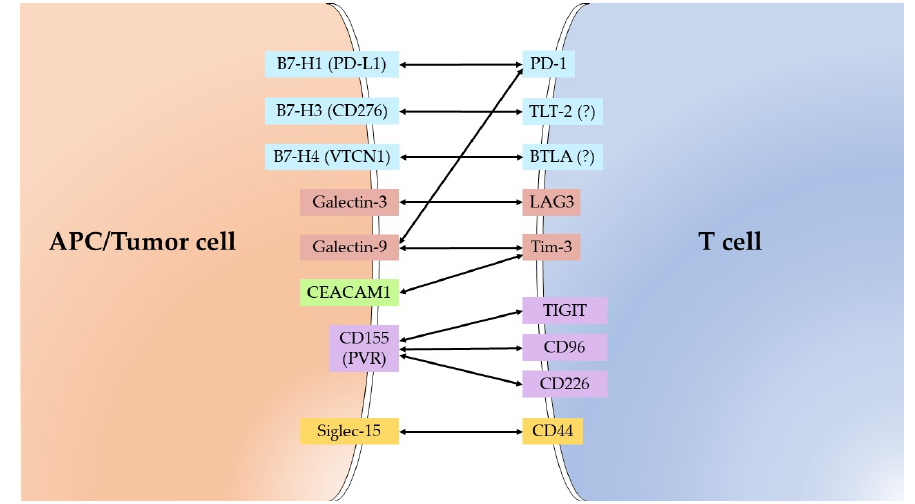
Figure 1. The ligands of immune checkpoint (left) and their receptors. (?) – putative receptor. Table 1. Immune checkpoint names and their receptors or substrates.